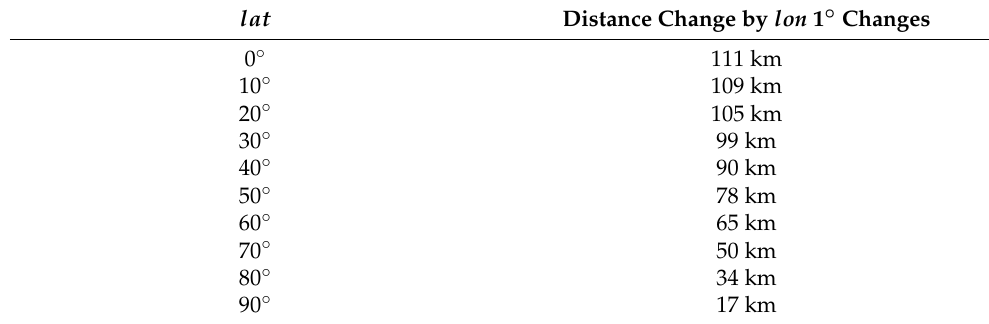
Table 3. Distance changes by lon 1 ◦